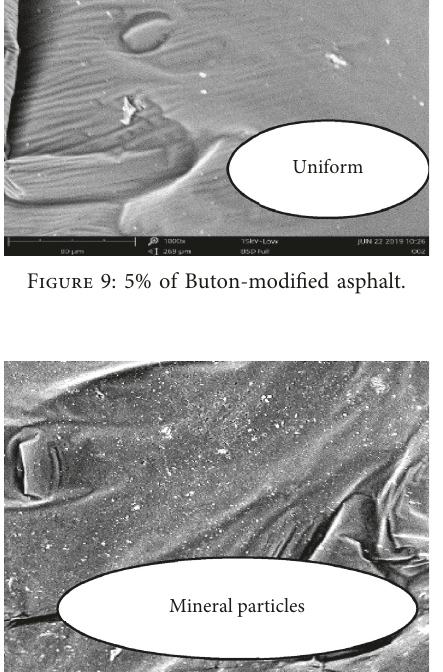
Figure 13: Infrared spectrum analysis of Buton